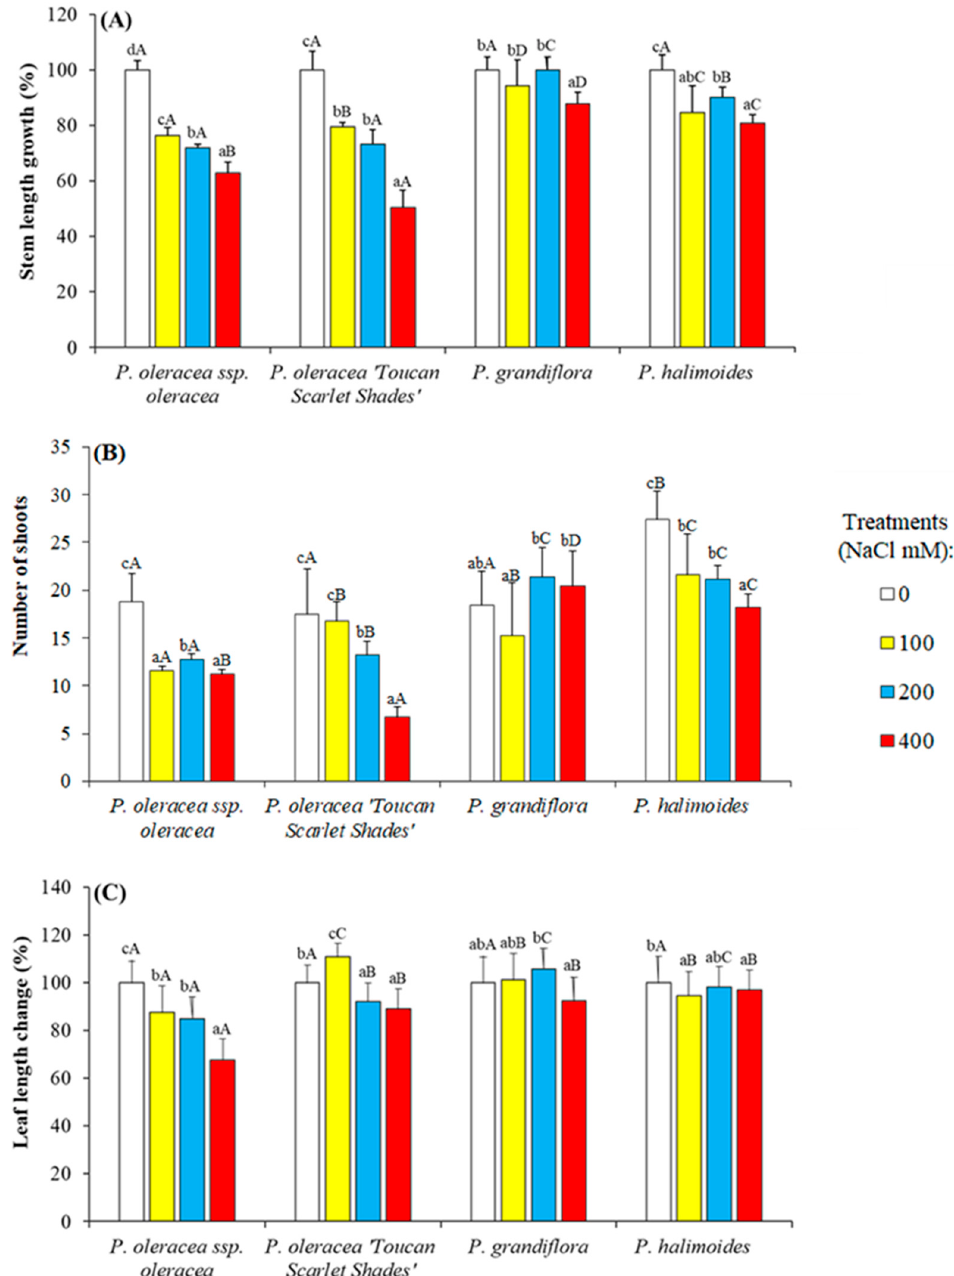
Figure 1. Measured growth parameters in the four studied Portulaca genotypes after 5 weeks of applied salt stress. ( A ) Stem length growth (%). For each genotype, values (means ± SE) are shown as percentages of the mean stem length of the control plants, considered 100%, ( B ) number of developed shoots by time of harvest, and ( C ) leaf length change (%). For each genotype, values (means ± SE) are shown as percentages of the mean leaf length of the control plants, considered 100%. Di ff erent lowercase letters within each genotype indicate significant di ff erences among the treatments and di ff erent capital letters indicate significant di ff erences among the genotypes undergoing the same treatment according to Tukey’s HSD test ( P < 0.05). Absolute values for the controls’ stem length are: 31.00 ± 1.04 cm ( P. oleracea L. subsp. oleracea ), 32.25 ± 2.20 cm ( P. oleracea “Toucan Scarlet Shades”), 19.60 ± 0.92 cm ( P. grandiflora ) and 18.20 ± 0.96 cm (P. halimoides ). Absolute values for the controls’ leaf length are: 4.00 ± 0.22 cm ( P. oleracea L. subsp. oleracea ), 2.93 ± 0.17 cm ( P. oleracea “Toucan Scarlet Shades”), 2.6 1 ± 0.12 cm ( P. grandiflora ), 3.36 ± 0.09 cm) and 1.13 ± 0.05 cm (P. halimoides